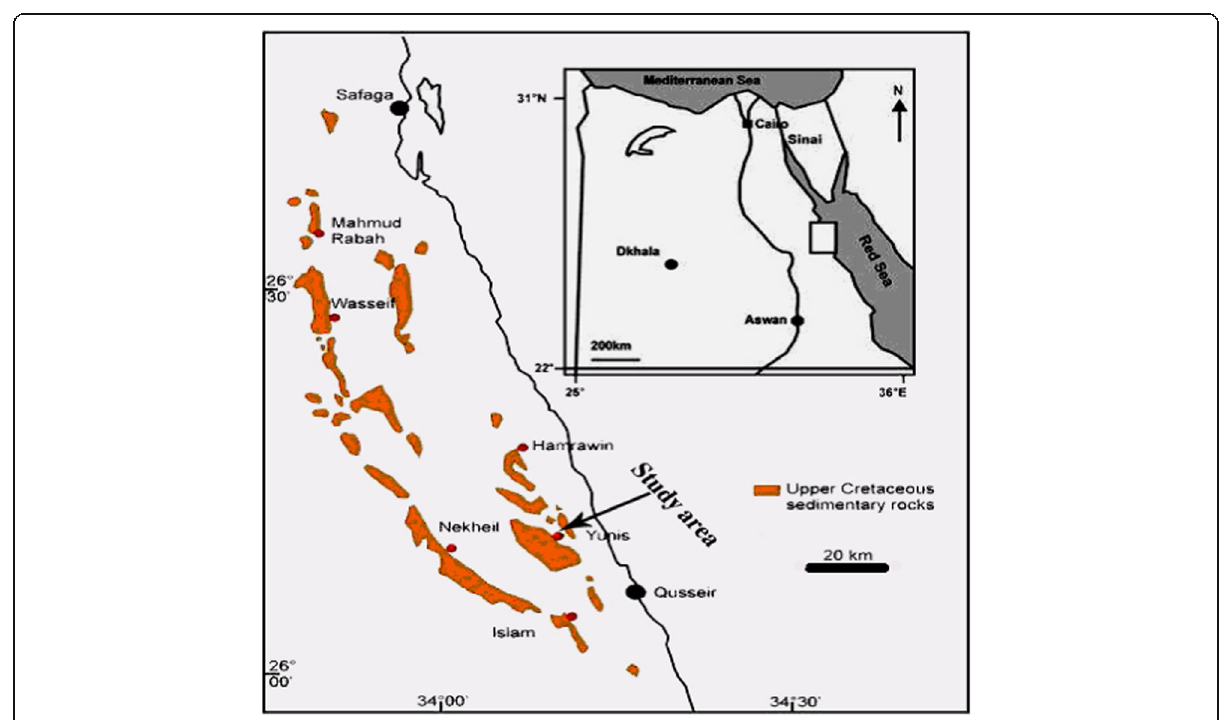
Fig. 1 Location map of the studied area